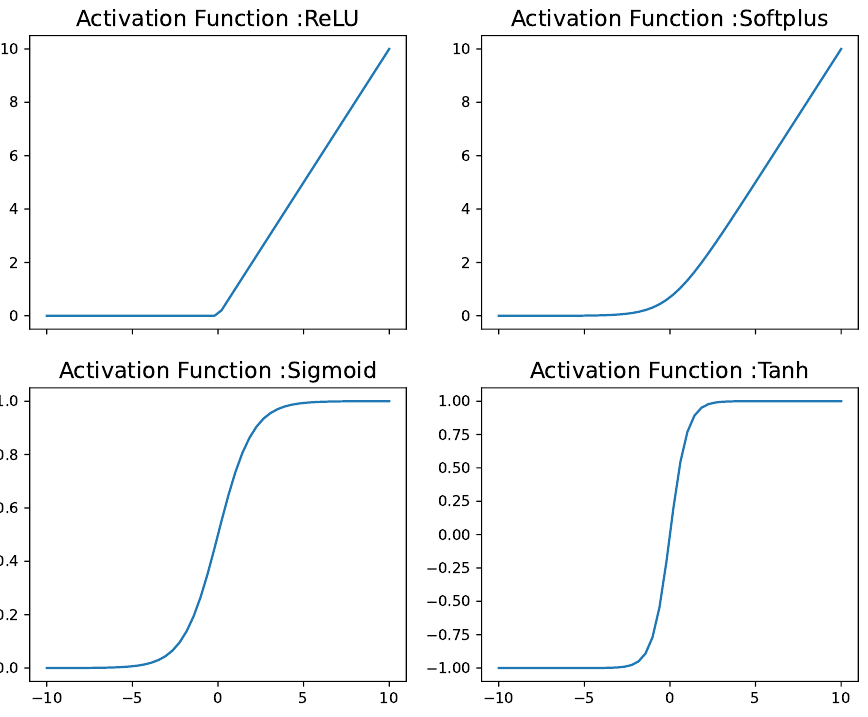
Figure 8. Different activation functions